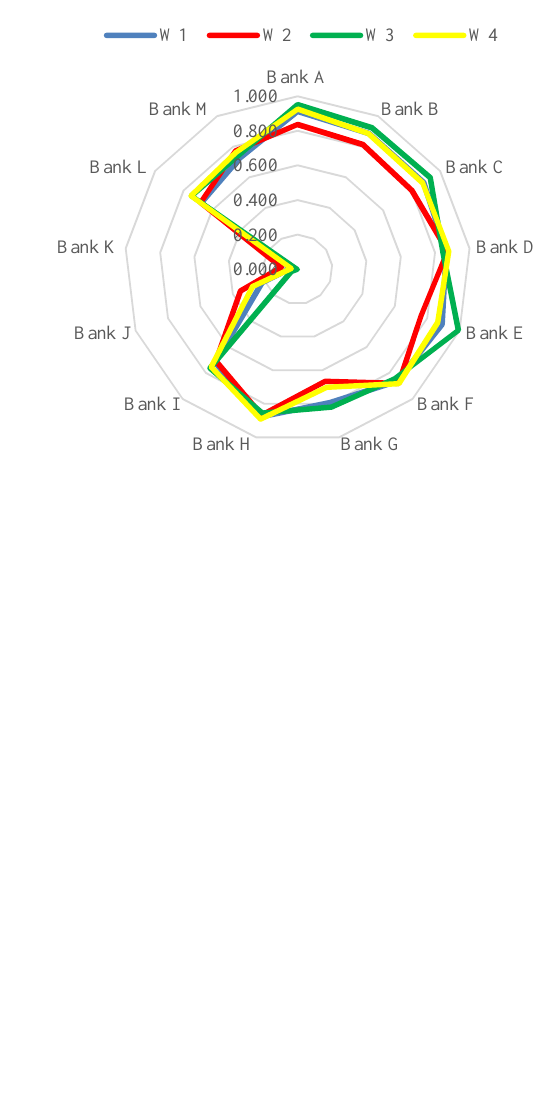
Figure 4. Resistance of commercial banks to potential COVID-19 pandemic impacts as determined by TOPSIS taking into account different weighting systems (Option